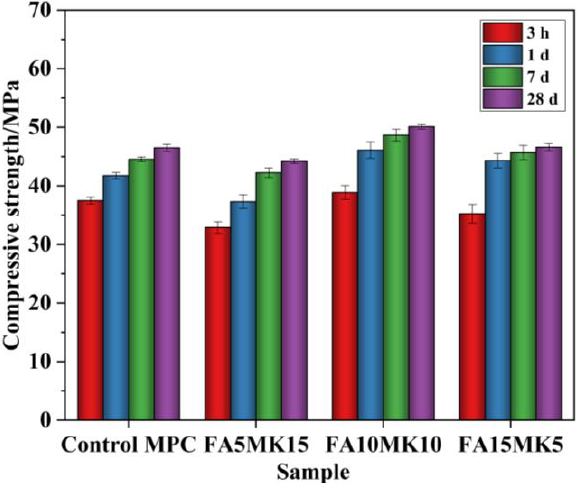
Figure 17. MPC compressive strength with the addition of compound powder.